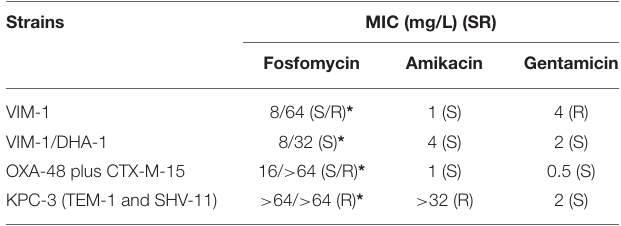
TABLE 1 | MICs for the carbapenem-resistant Klebsiella pneumoniae strains used in the studies. Strains